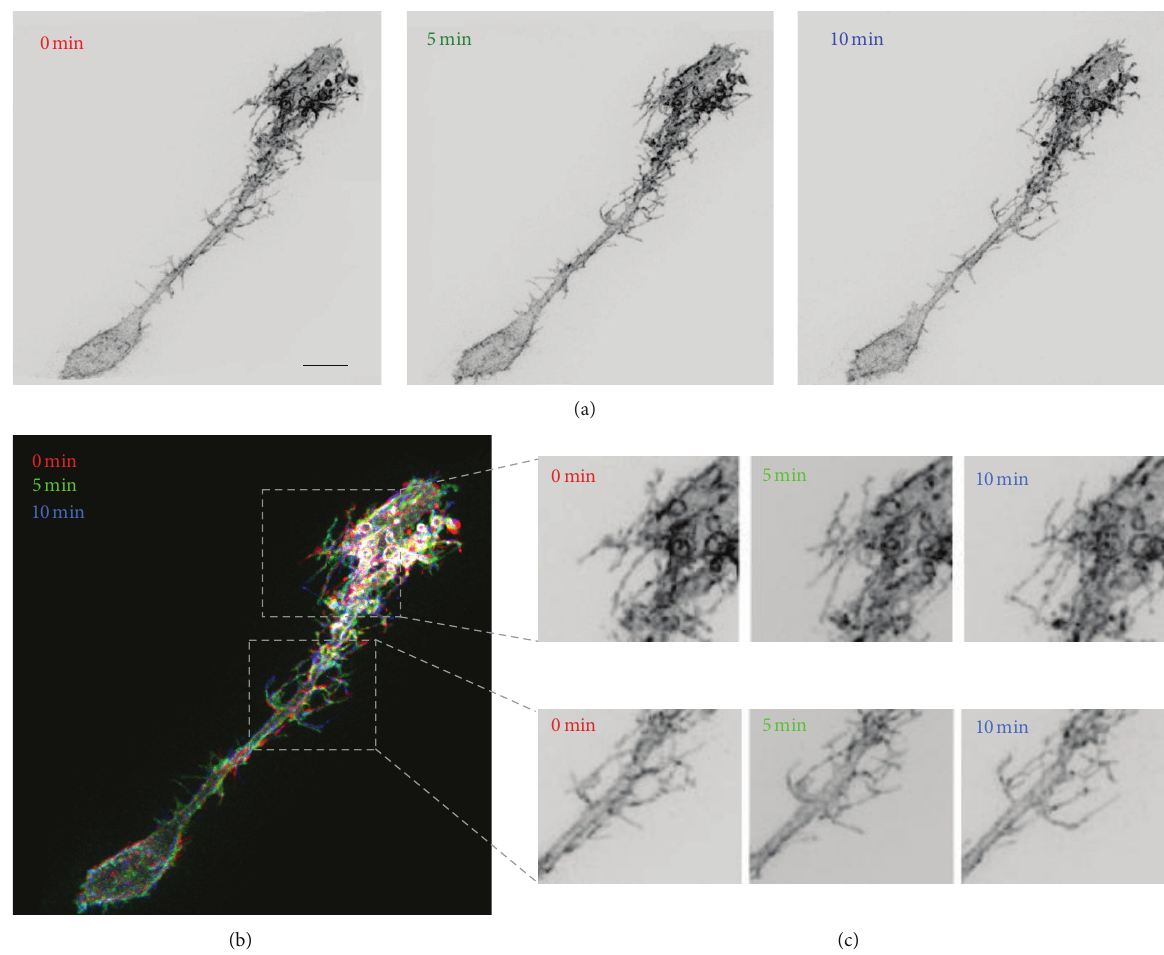
Figure 1: Radial glia process movement in vivo is apparent over a timescale of minutes. (a) Maximum intensity projections of two-photon microscope z-series images of a radial glia cell expressing farnesylated EGFP in the intact tadpole brain. (b) RGB overlay of the time-lapse images of a radial glia cell where red denotes the position of the cell at 0 minutes, green after 5 minutes, and blue after 10 minutes of imaging. (c) Magnified images of several highly dynamic sites from the radial glial cell shown in (b). Scale bar = 10 𝜇